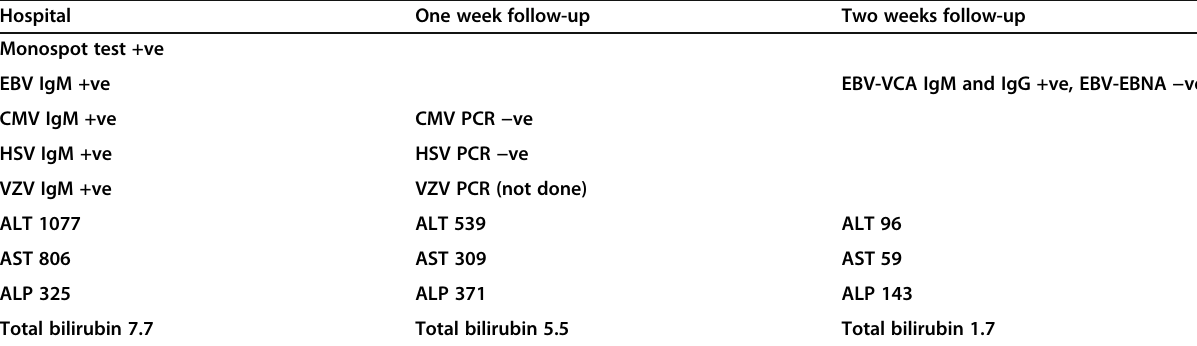
Table 1 Patient ’ s LFTs, serological and virological tests during admission, one week and two weeks follow-up Hospital One week